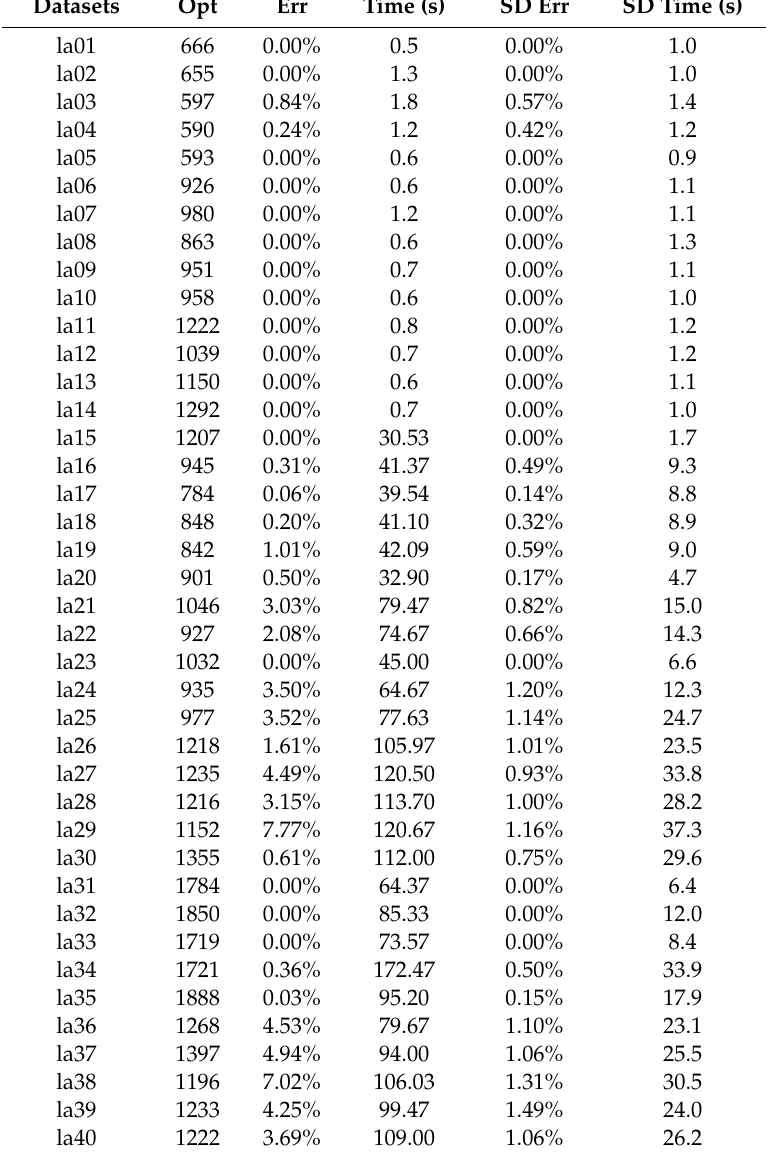
Table 7. Mean errors, computations times (s) and their standard deviations for the analyzed JSSP